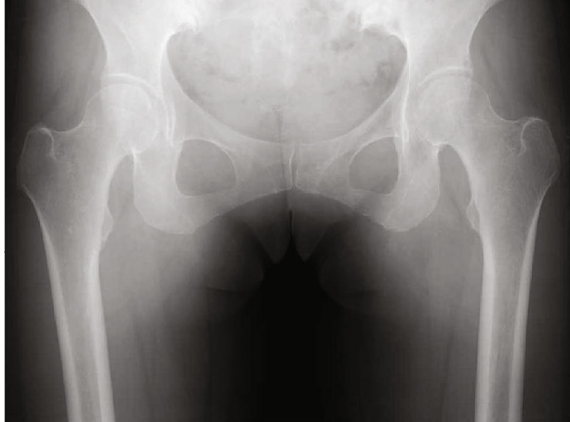
Figure 3: Radiograph of the hip 10 months after